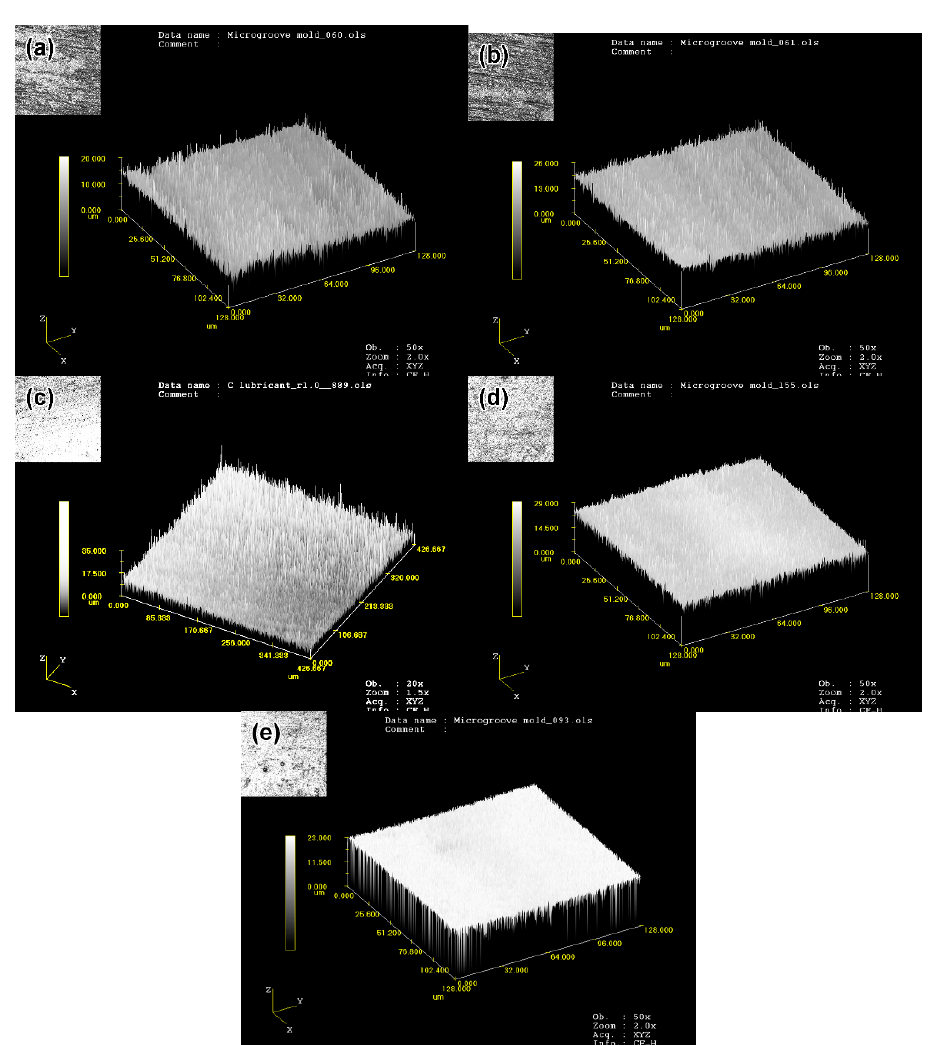
Figure 17. Three-dimensional morphology of ZrO 2 nozzles with multi-micro-holes at different processing stages ( a ) mold of nozzles, ( b ) molded, ( c ) debound, ( d ) sintered at 1500 ◦ C with 200 nm, ( e ) sintered at 1250 ◦ C with 100